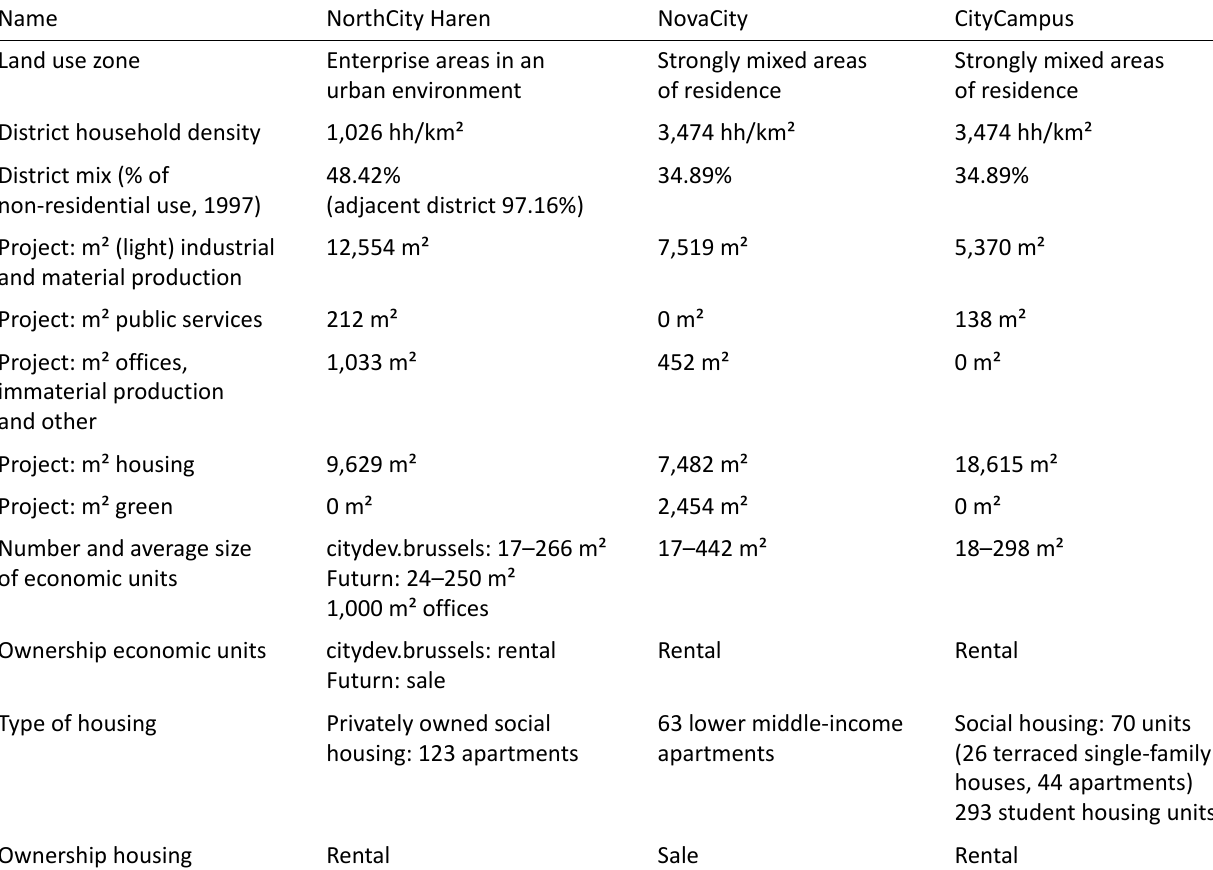
Table 3. Basic characteristics of three live‐work mix projects in the Brussels Capital